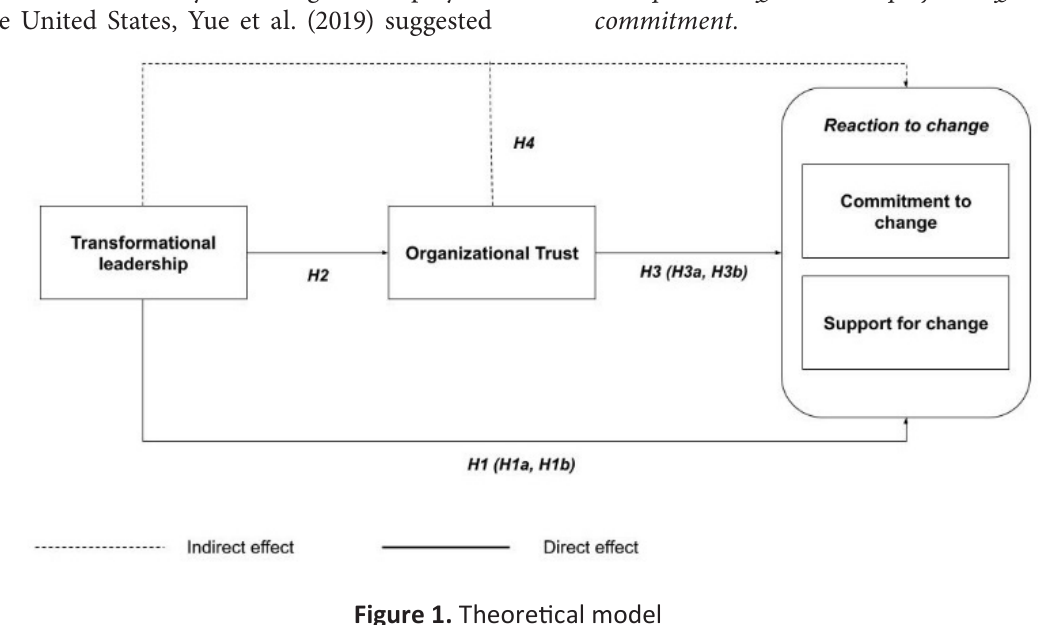
Figure 1. Theoretical